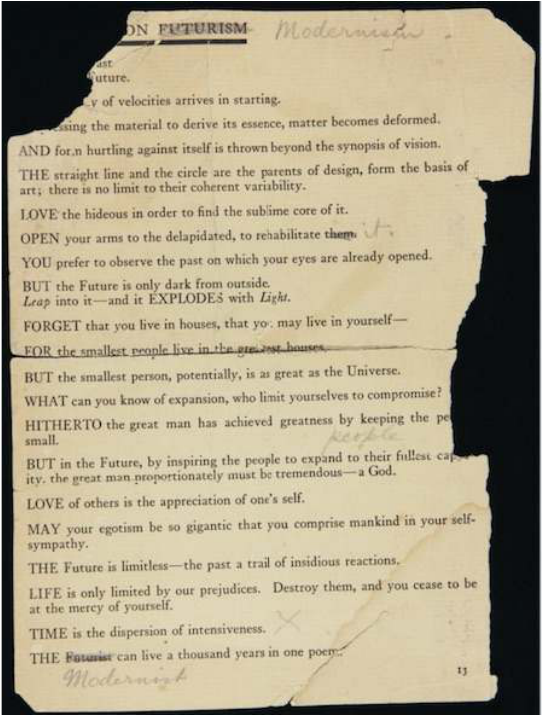
Figure 1: “Aphorisms on